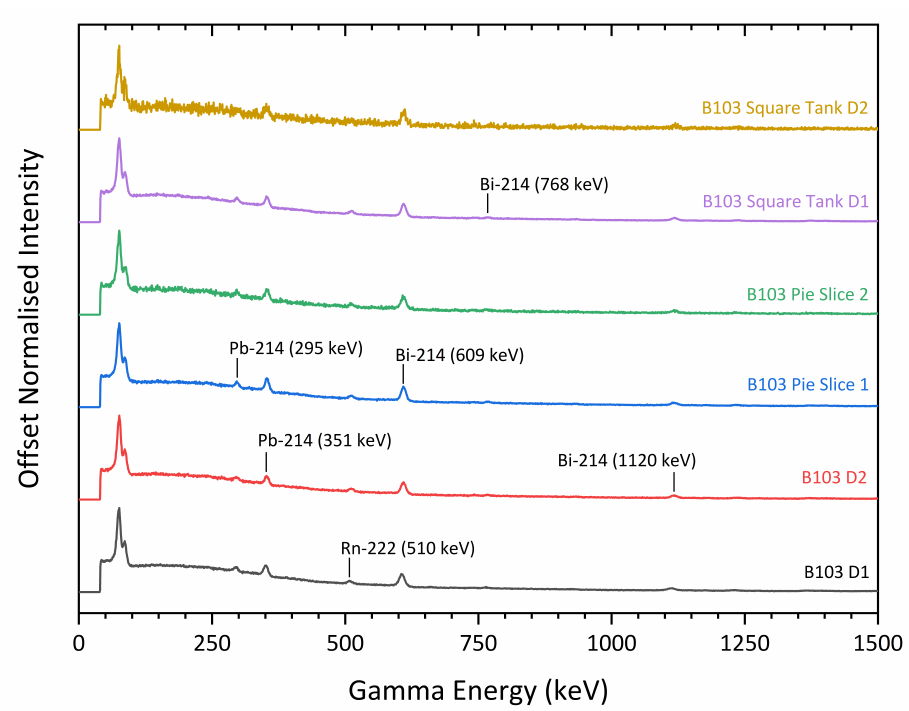
Figure 7. Comparison of gamma spectra captured by the CC-RIAS at different deployment locations within the REE ore processing facilities of PChP. Photopeaks at different energies correspond to decay products of NORM (U and Th series), in varying concentrations as isotopes are selectively removed in the REE purification process. Count rates were normalised to facilitate comparison of spectral recordings at different locations. All graphs are on a linear scale.